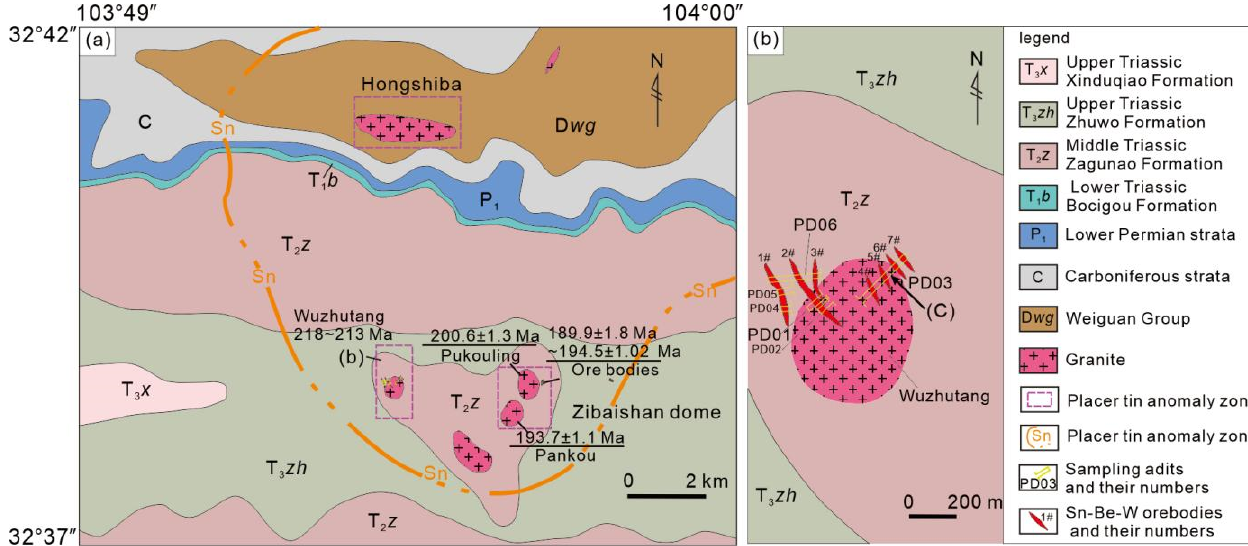
Figure 2. ( a ) Simplified regional geological map of the Xuebaoding W–Be–Sn mining area. ( b ) Geological map of the Wuzhutang granite. The age of the Pukouling and Pankou granite follows [38]. Overall, the metallogenic characteristics of the western part of the dome are similar to those of the eastern part [38]. However, several differences between them have been identified during our field observations: (1) In the western part of the dome, the W- enriched ore veins extend from the interior of the Wuzhutang granite to the marble, which is similar to that in the eastern (the Pankou and Pukouling granites) part of the dome [24,32]. Notably, we observed that W–Sn–Be ore veins still occur in the Zhuwo Formation (T 3 zw ) which is nearly 2 km away from the eastern side of the Pukouling granite (Figure 2a); (2) Tourmaline is almost absent in the granites and ore veins in the western part; and (3) The scale and intensity of mineralization in the western part are smaller and lower, respectively, than those in the eastern part of the